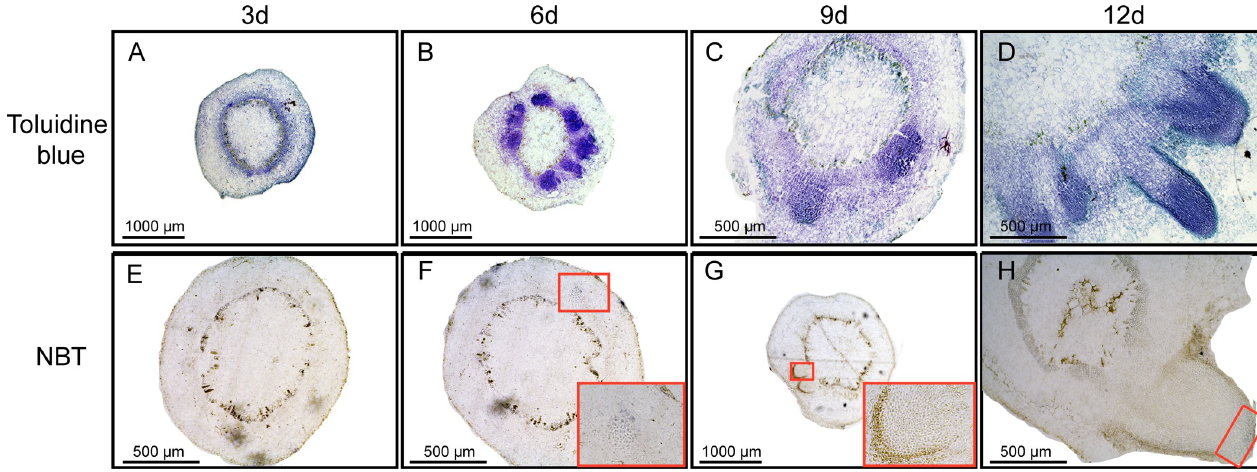
Fig 6. Reactive oxygen species are participated in adventitious root formation in apple stem cuttings. Stem cross-sections of ‘Gala’ apples taken at 3, 6, 9, and 12 days after subculture on rooting medium and stained with toluidine blue (A-D) and Nitro blue tetrazolium (NBT; O 2- ) (E-H), respectively. Scale bars (1000 μ m, 500 μ m, and 200 μ m) are indicated in the figures. Pictures in red boxes show a 20 � view of the stem cuttings in (F, G). The rectangle indicates NBT- stained root tip in (H).